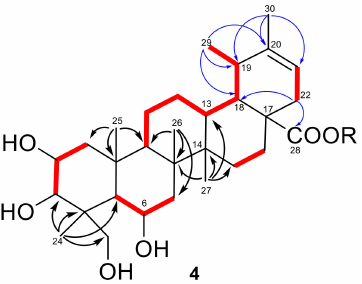
Figure 3. COSY (in red bold) and key H → C HMBC (black/blue arrows) correlations detected for 4 . As for ring E, the HMBC cross-peaks (in blue in Figure 3) of H 3 -30 ( δ H 1.65, s) with C-19 and the sp 2 C-20 ( δ C 144) and C-21, and those of H 3 -29 ( δ H 1.04, d, 8.0) with C-18, C-19 and C-20 ( δ C 144), were diagnostic for the presence of a trisubstituted double bond at ∆ 20,21 . Moreover, the key HMBC correlations of H 2 -22 with C-18 ( δ C 49.4) and C-28 ( δ C 176.4) placed the ester carbonyl at C-28 and confirmed the planar structure of the aglycone of 4 as an ursene triterpenoid, sharing the same carbon framework of madecassoside but showing a different double bond